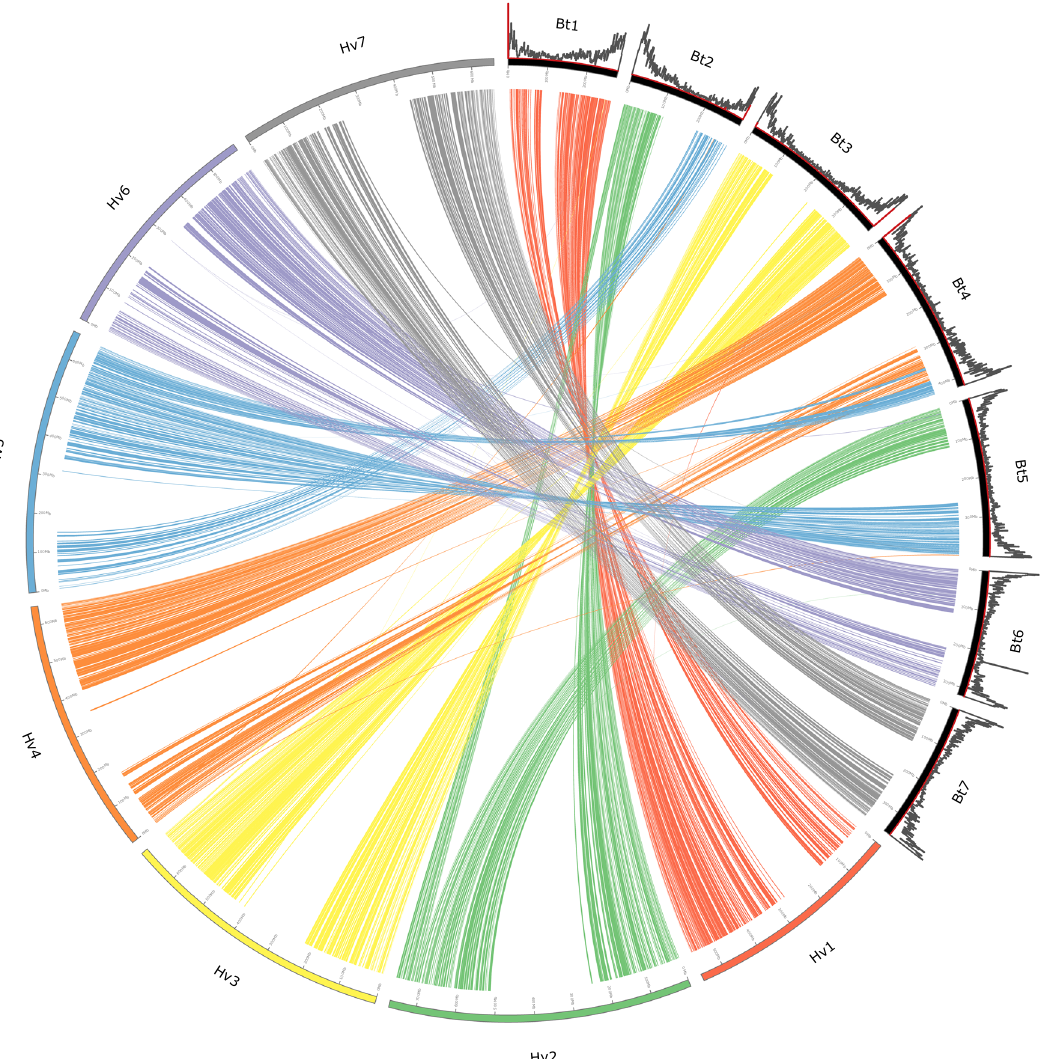
Fig. 1 Circos synteny plot depicting the synteny between the Bromus tectorum draft reference genome and a previously published barley genome. Strips and barley chromosomes colored in reference to the corresponding barley chromosomes. Histograms above B. tectorum chromosomes are coded black for gene density and red for telomere repeats for each 1 Mb window of the